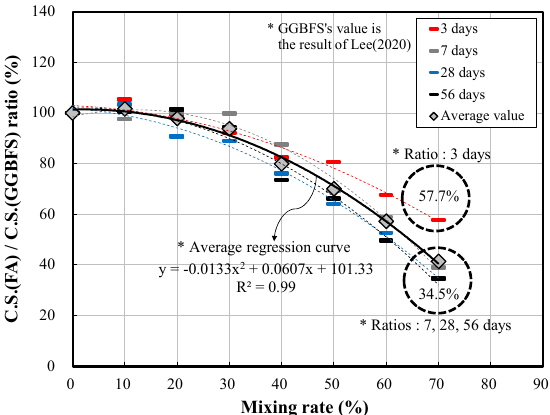
Figure 8. Result of compressive strength (FA)/compressive strength (GGBFS) as measured by Lee (adapted from [26]) in terms of the mixing rate.